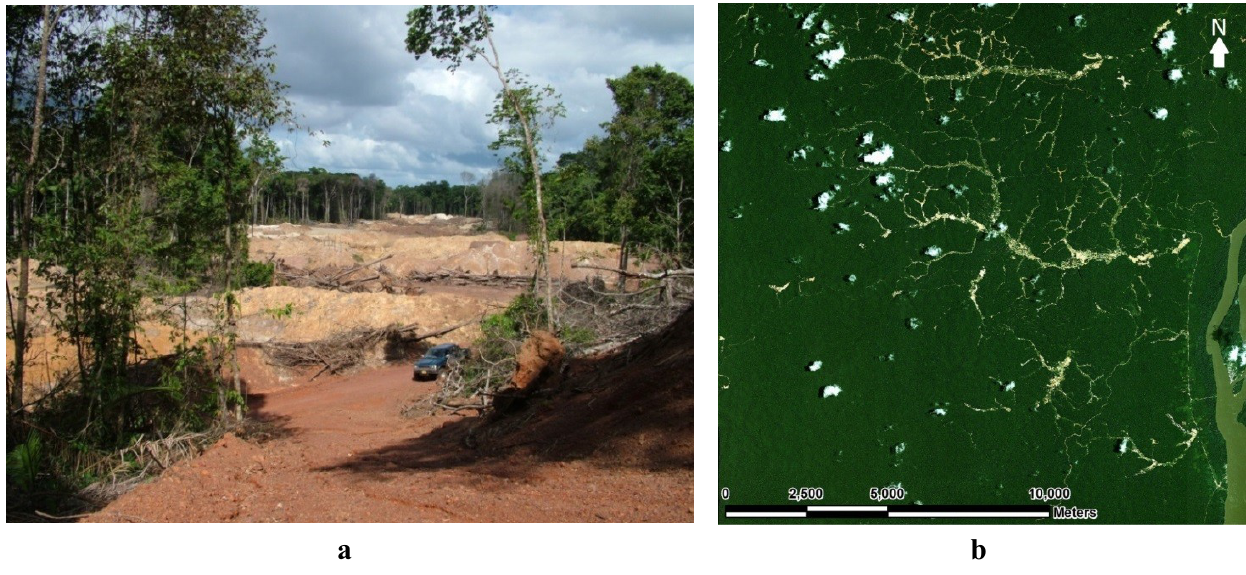
Figure 3. Artisanal gold mining, soil erosion and stream sedimentation in Suriname; ( a ) In 2005, the riparian forest was cleared at a recently developed gold mining site along Maykabuka Creek, Gros Rosebel Area (05°04′45′′ N, 55°16′9′′ W), In 2001, the then pristine Maykabuka catchment still had the forest canopy closing over the stream and the site in the photograph was used as a control in a 1994–2001 study of the effects of gold mining related erosion on instream habitat and fish community [34], (capture date of photograph 8 December 2006); ( b ) Satellite image showing extensive clearance of riparian forest associated with small-scale gold mining in the catchments of the Merian (05°06′ N, 54°31′ W) and Tumatu rainforest streams, Marowijne River Basin, Suriname, September 2010, Source Quickbird; ( c ) High pressure water is used to remove the topsoil and then the gold-bearing layer of sand and clay, (capture date photograph of 7 May 2008); ( d ) In a sluice box heavy particles and gold are gravity separated from the superfluous lighter particles in the slurry which then are discharged into an abandoned mining pit in the adjacent forest or stream, (capture date of photograph 7 May 2008); ( e ) Downstream a mining site in the Gros Rosebel Area, a shallow dry-season pool in a turbid rainforest stream with intact riparian forest and closed canopy cover (4°30′ N, 55°20′ W) has low dissolved oxygen (1.3 mg/L) and an unusually low fish diversity virtually monopolized by the auchenipterid catfish Trachelyopterus galeatus , (capture date of photograph 5 November 2008); ( f ) An abandoned mine site in the Merian Creek catchment (05°06′44′′ N, 54°31′16′′ W) shows slow riparian forest regeneration, abundant growth of grasses and a shallow, turbid, sunlit stream, (capture date of photograph 26 November 2011). © Jan H.